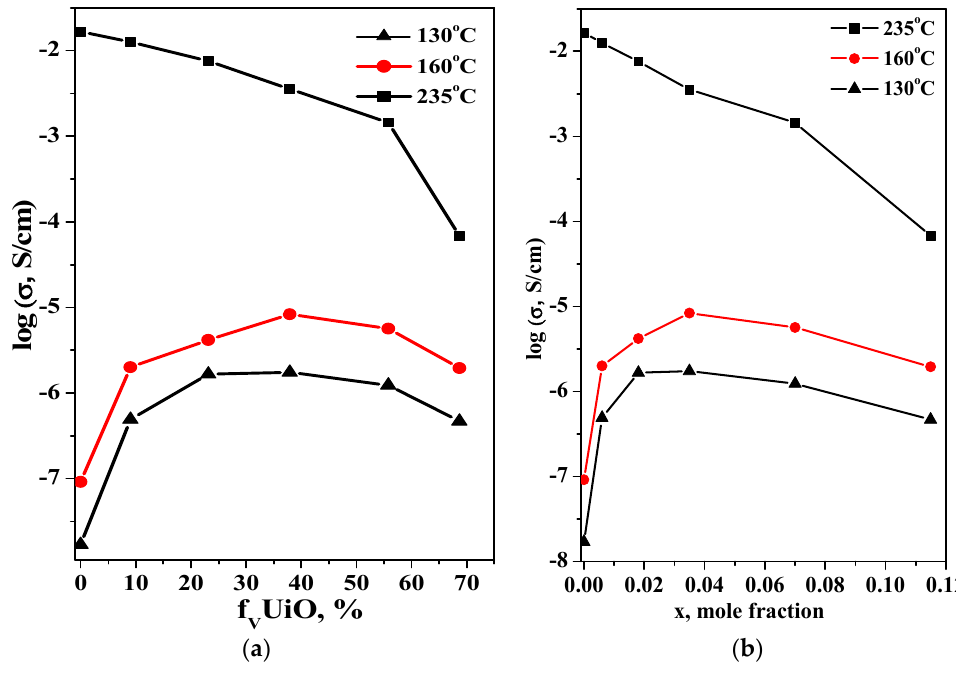
Figure 8. Temperature dependences of conductivity for initial CsH 2 PO 4 and (1 − x)CsH 2 PO 4 -xUiO-66 of different compositions; x = 0.006–0.115 (cooling regime, 0.5–1 deg/min, P H2O ~0.3 atm at 180–250 °C, and in air with RH=15–20% at 50–180 °C).